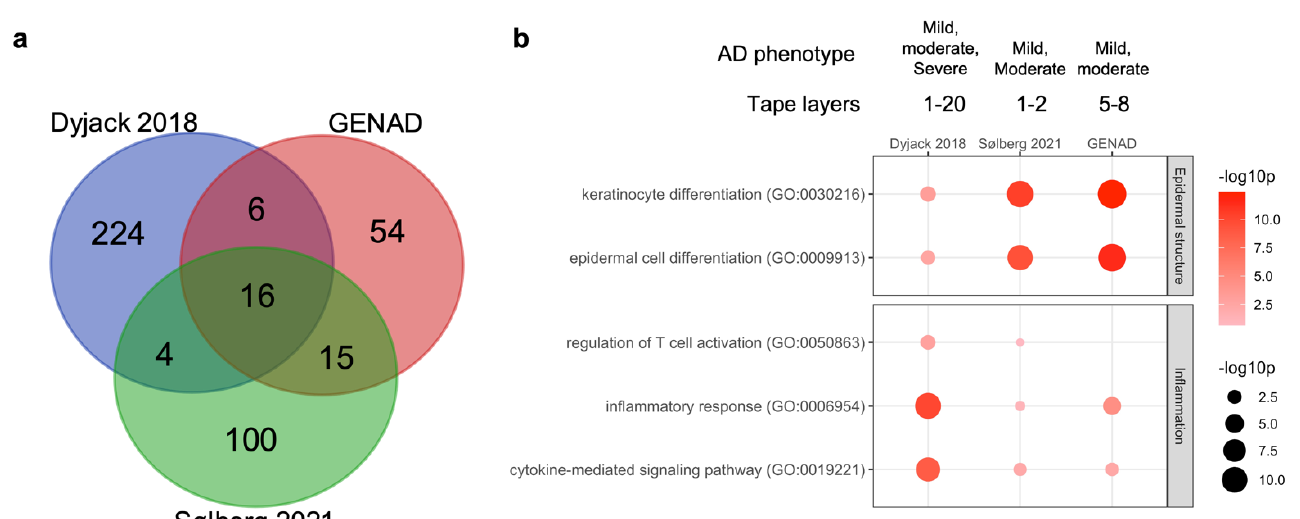
Figure 5. Comparison of transcriptome data from three studies: GENAD, Dyjack 2018 [14], and Sølberg 2021 [13]. ( a ) Venn diagram showing the overlap of AD DEGs; ( b ) bubble plot showing the most enriched pathways. The AD phenotype and tape layers used in the three studies are indicated above the plot.